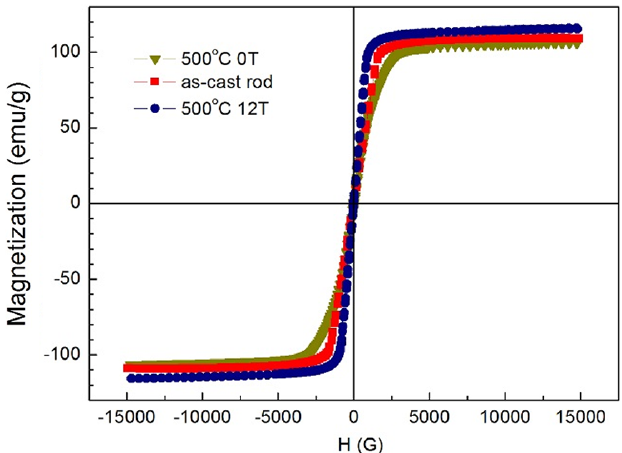
Figure 4. Hysteresis loops for Fe